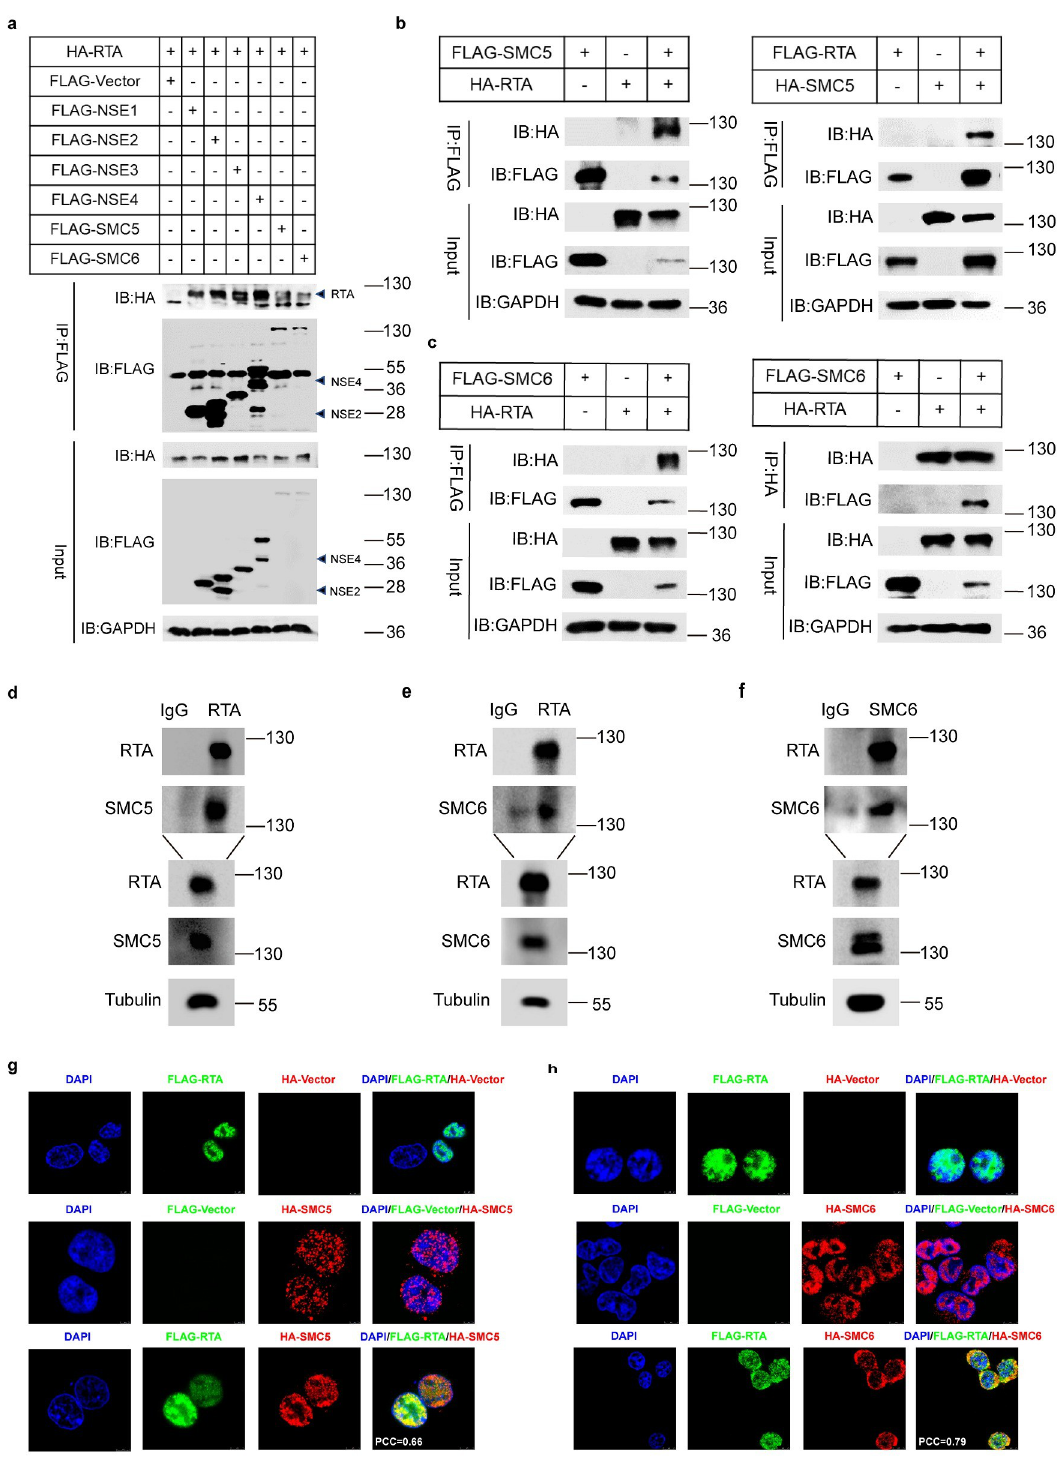
Fig 7. RTA interacts with the SMC5/6 complex. (a) RTA interacts with the SMC5/6 complex. HEK293T cells were transfected with HA-RTA along with FLAG-Vector or all proteins of the SMC5/6 complex. 40h post-transfection, cell lysates were collected and immunoprecipitated with anti-FLAG antibody followed by analyzing with the indicated antibodies. (b) Interaction between SMC5 and RTA. Left panel, HEK293T cells were transfected with HA-RTA alone or FLAG-SMC5 alone or HA-RTA together with FLAG-SMC5. 40h post-transfection, cell lysates were immunoprecipitated with anti-FLAG antibody and analyzed by indicated